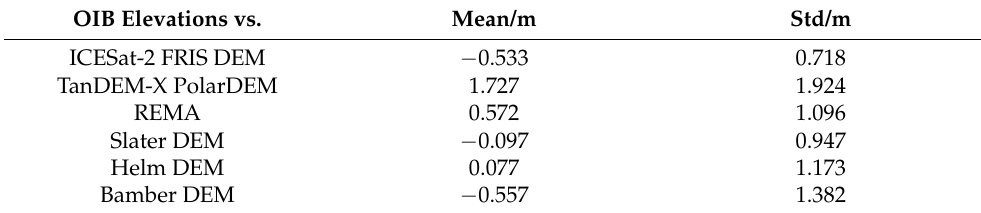
Table 8. Comparison between the six DEMs and OIB elevations in FRIS. OIB Elevations vs.